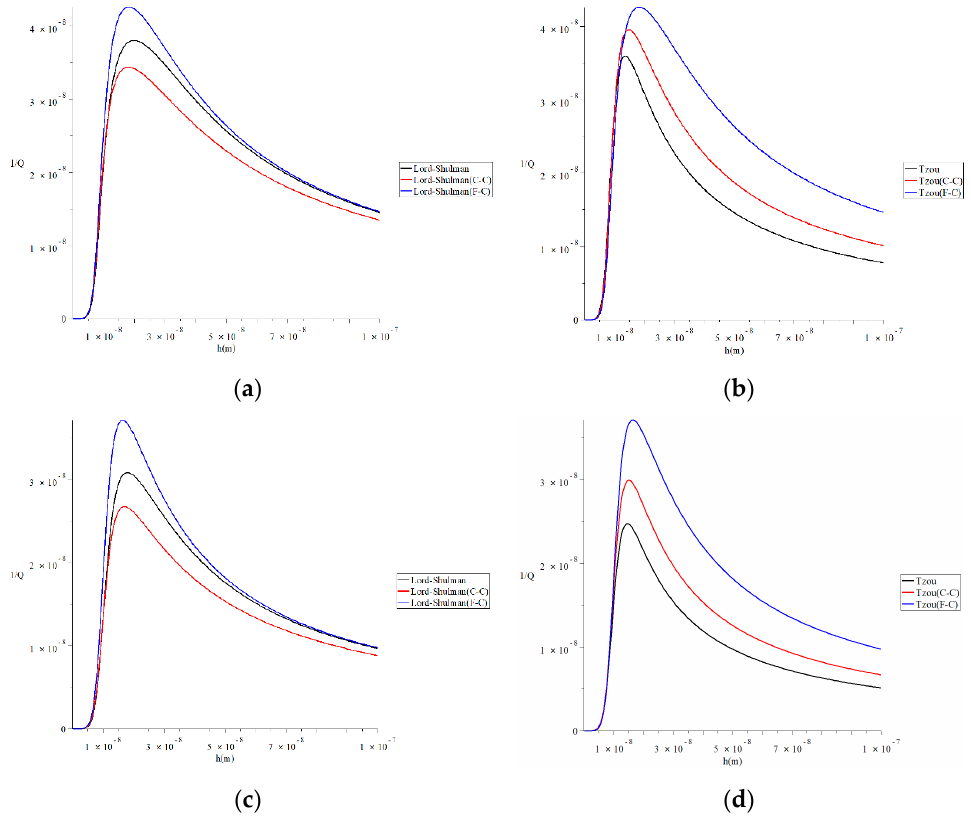
Figure 8. The thermal quality factor for different models with various values of the beam’s length when q = 4.73/ L , b = 4 h , F = 10 − 40 N , and β = 0.6. ( a ) The thermal quality factor for the Lord–Shulman model when L = 30 h; ( b ) the thermal quality factor for the Tzou model when L = 30 h; ( c ) the thermal quality factor for the Lord-Shulman model when L = 50 h; ( d ) the thermal quality factor for the Tzou model when L = 50 h .